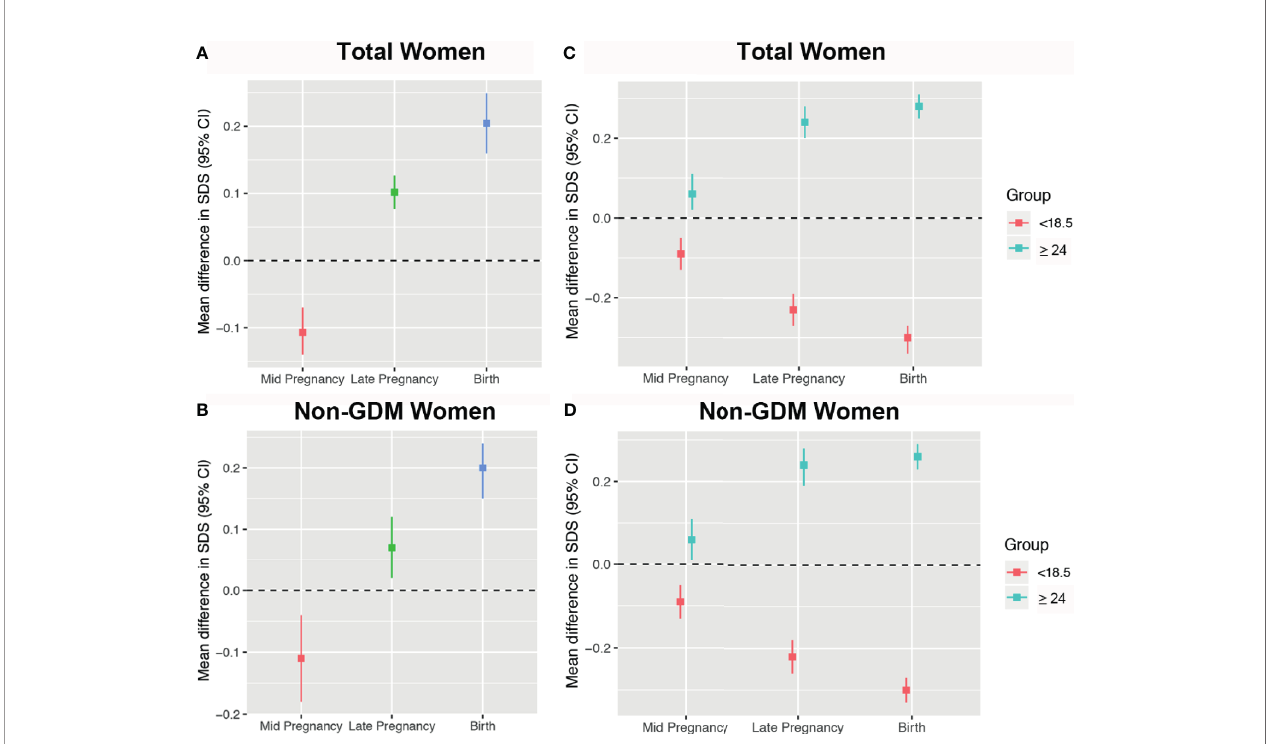
FIGURE 3 | Mean differences in estimated fetal weight (EFW) across pregnancy strati fi ed by early gestational diabetes mellitus (GDM) and pre-pregnancy body mass index (BMI). Women with non-early GDM are the reference group in panels (A, B) , represented by the black zero-line. Normal weight women are the reference group in panels (C, D) .